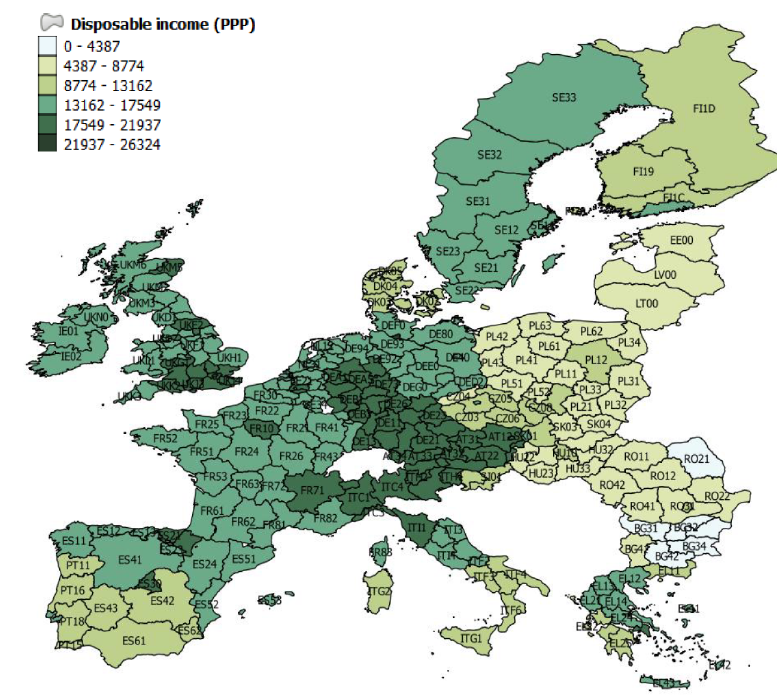
Figure 1: GDP per capita (EUR) –